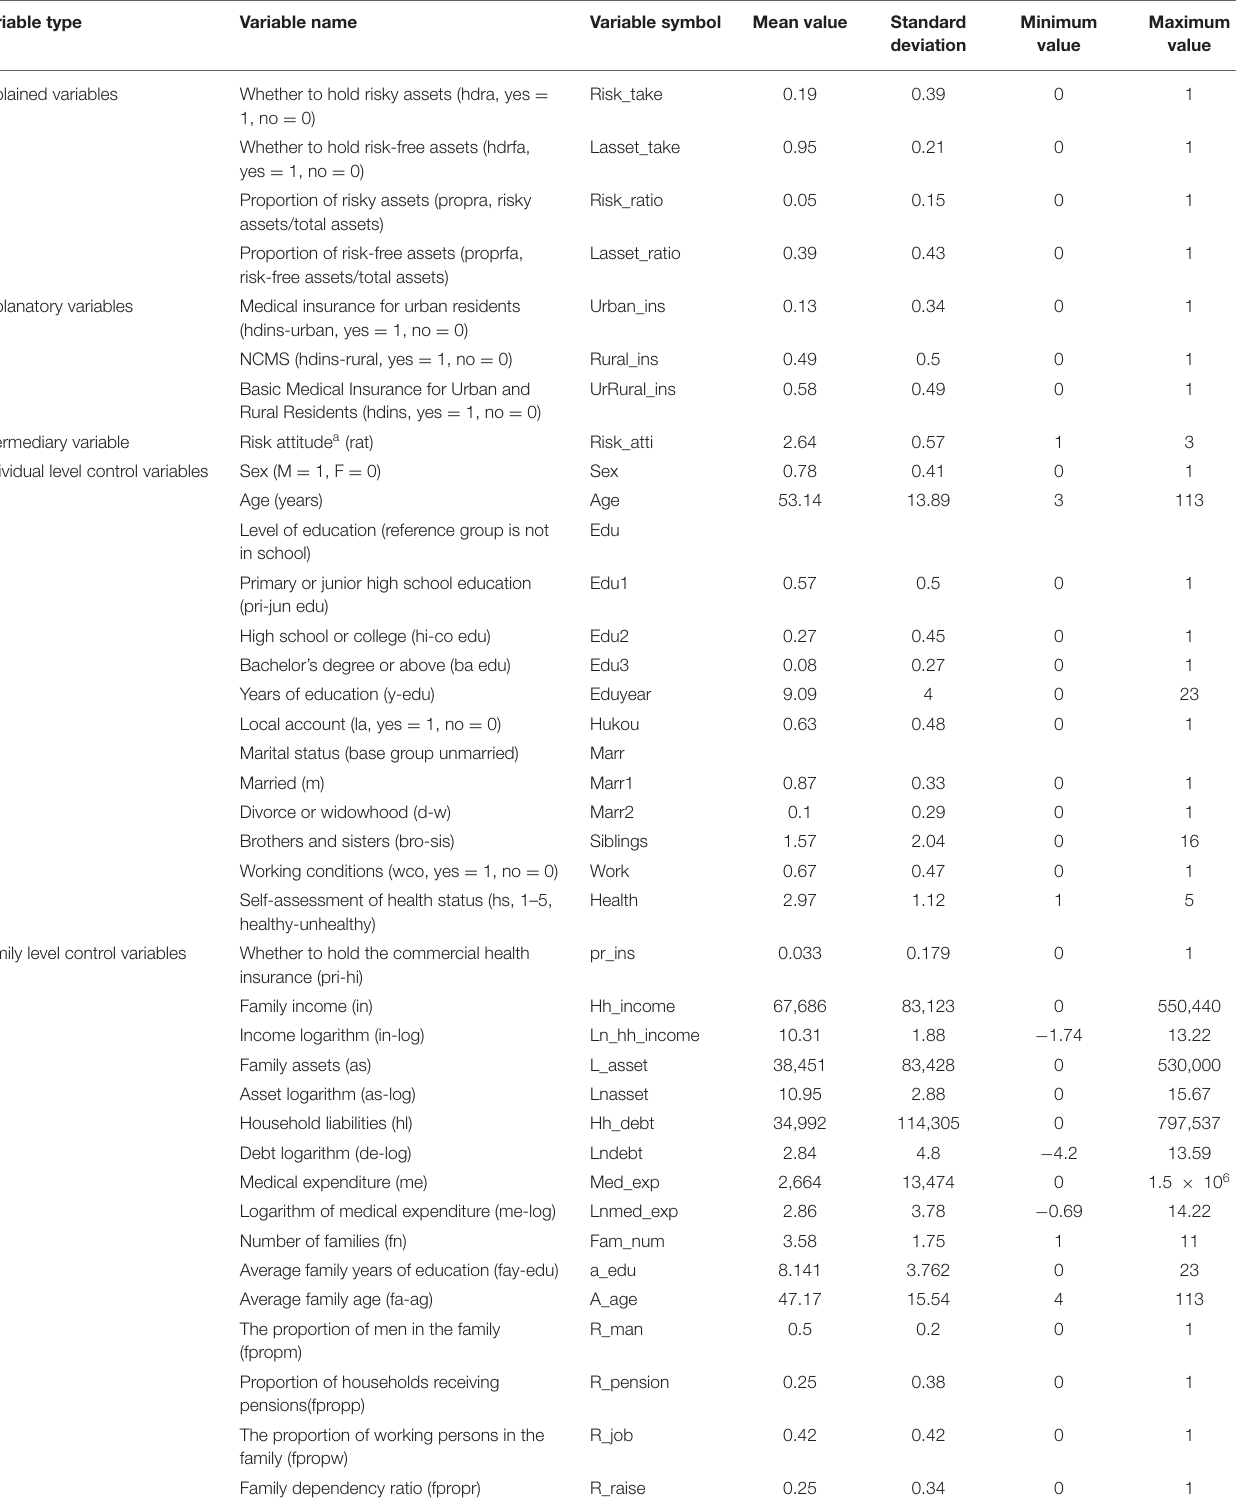
TABLE 1 | Descriptive statistics of